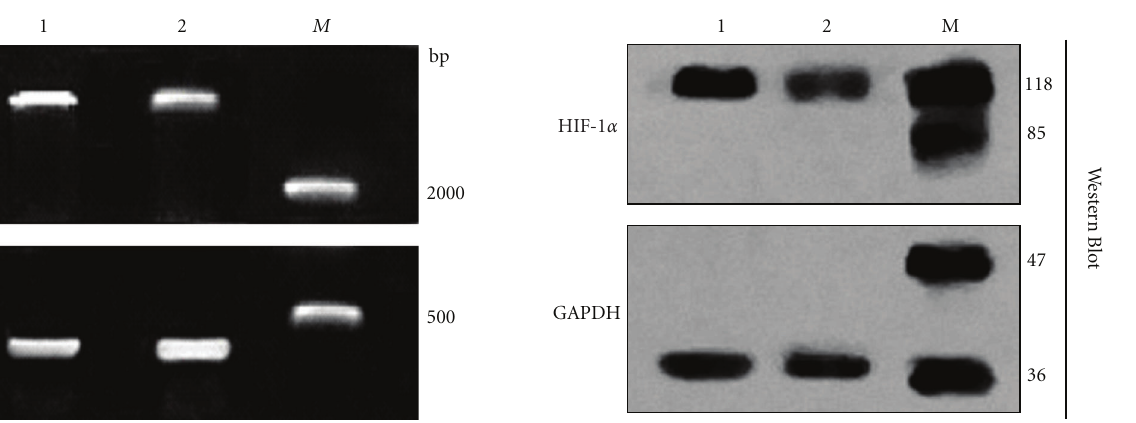
Figure 14: Expression of by Western blot. Lane 1 was for HIF-1 α - pcDNA 3 . 1 transfected MSCs and lane 2 for nontransfected, lane M (biotinylated protein